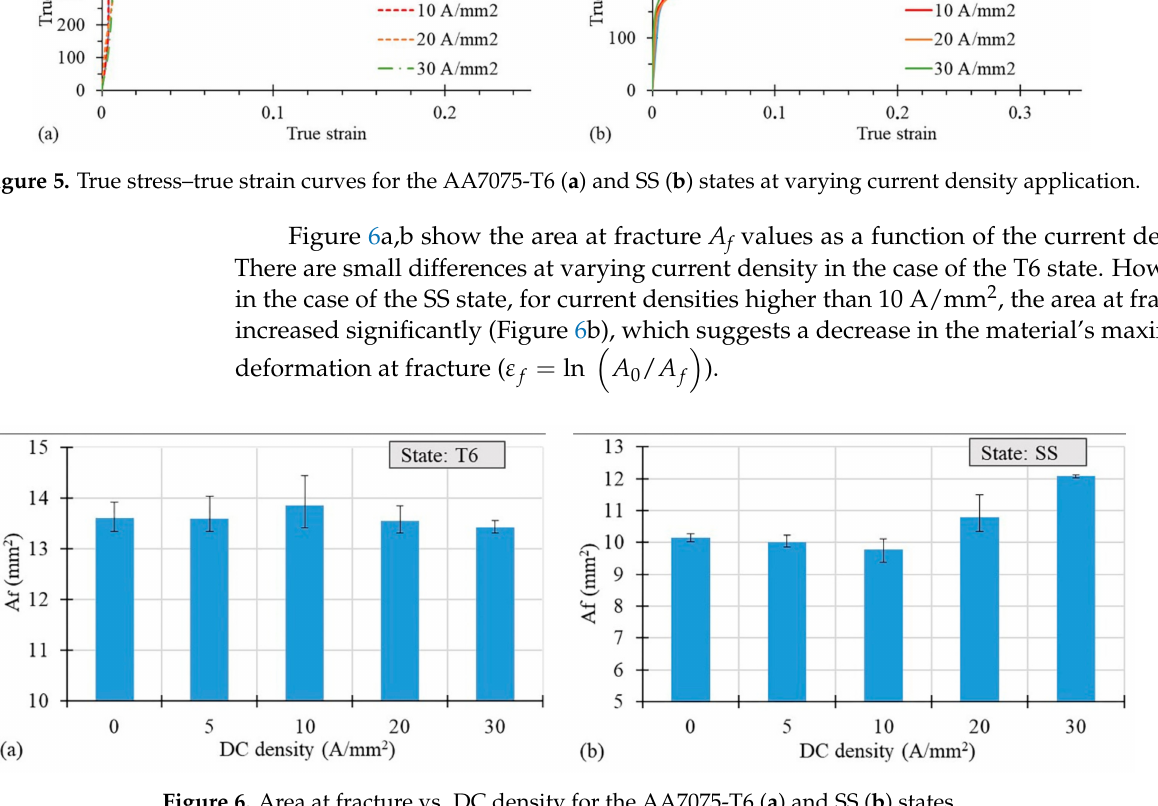
Figure 6. Area at fracture vs. DC density for the AA7075-T6 ( a ) and SS ( b ) states.